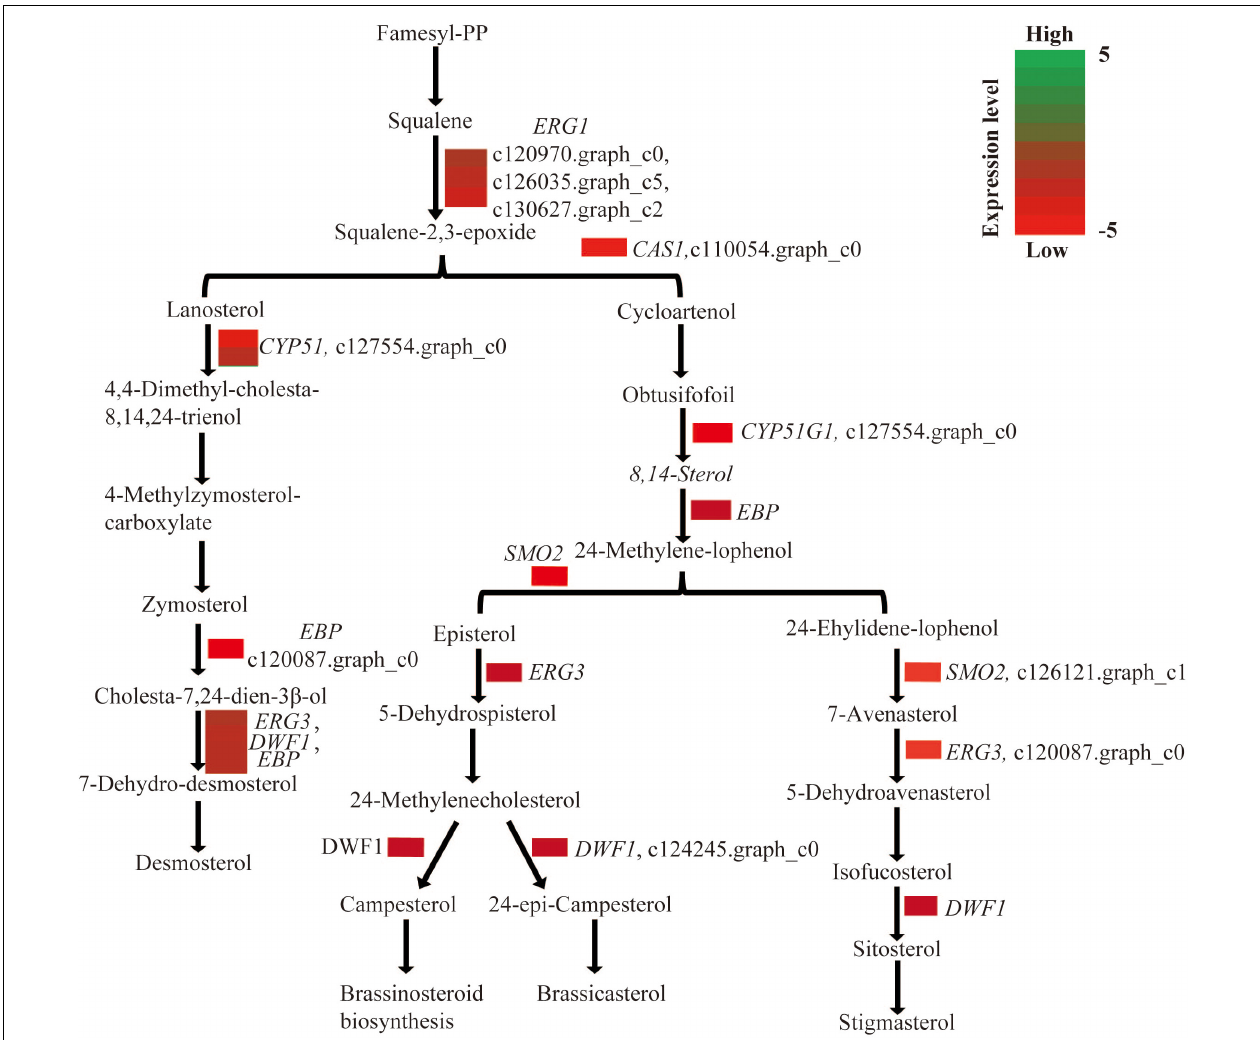
FIGURE 6 | Genes involved in brassinosteroid biosynthesis were repressed in white vs. pink petals.